Question: What style of plot is this figure drawn as?
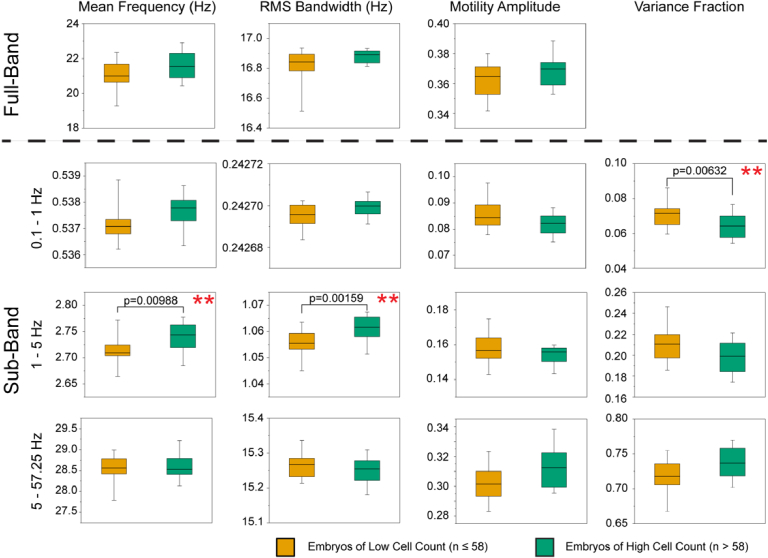
Answer: box